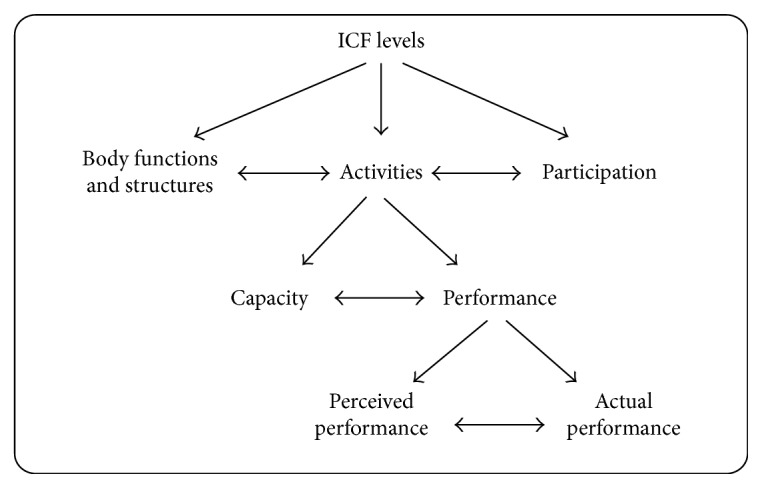
ICF levels and subdivision [109].